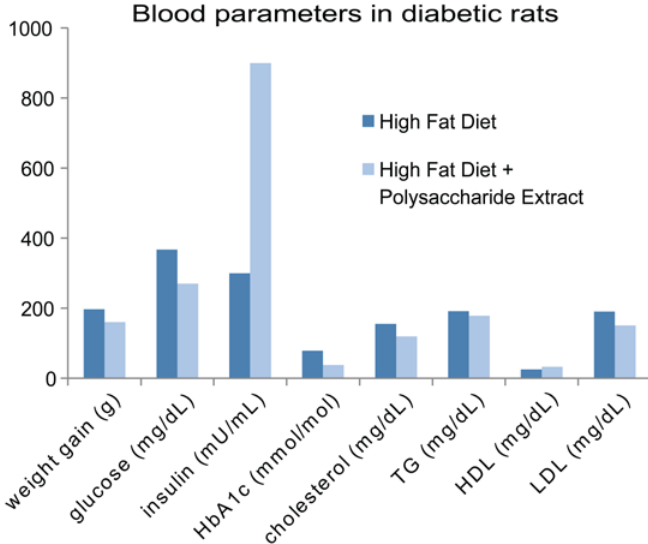
Figure 10. Addition of Pleurotus tuber-regium polysaccharide extract to a high fat diet in streptozotocin-induced diabetic rats improved blood parameters and was accompanied by reduced hepatic lipid peroxidation and increased hepatic superoxide dismutase and glutathione peroxidase activity and peroxisome proliferator activated receptor (PPAR)- α expression. Adapted from Huang, et al. [122].